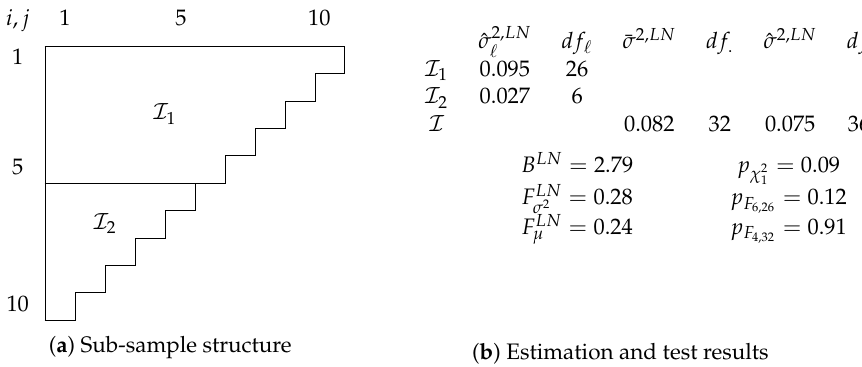
Figure 2. Log-normal chain-ladder model for Verrall et al. (2010) data. Sub-sample structure shown in ( a ), estimation and test results in ( b